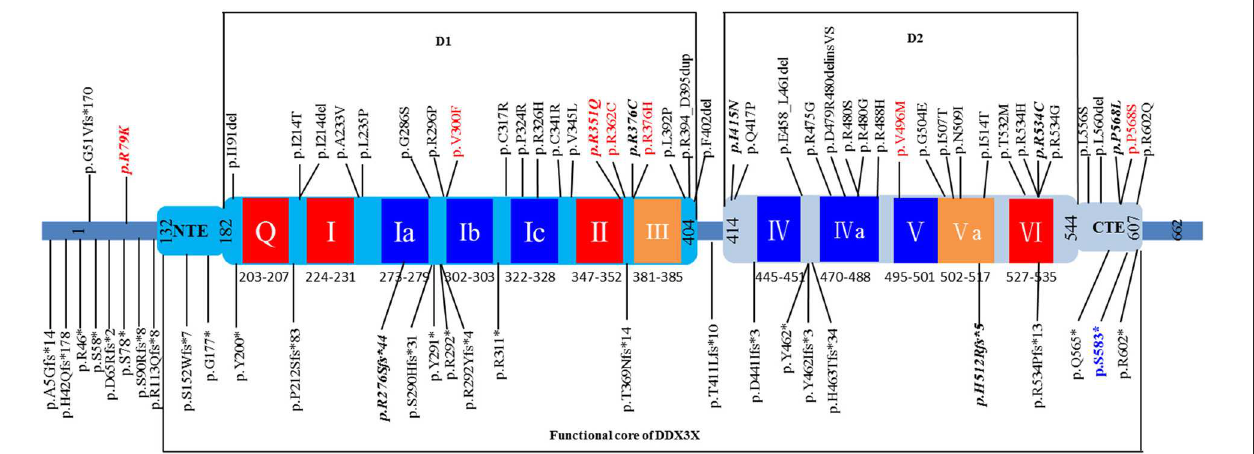
Frontiers in Pediatrics |